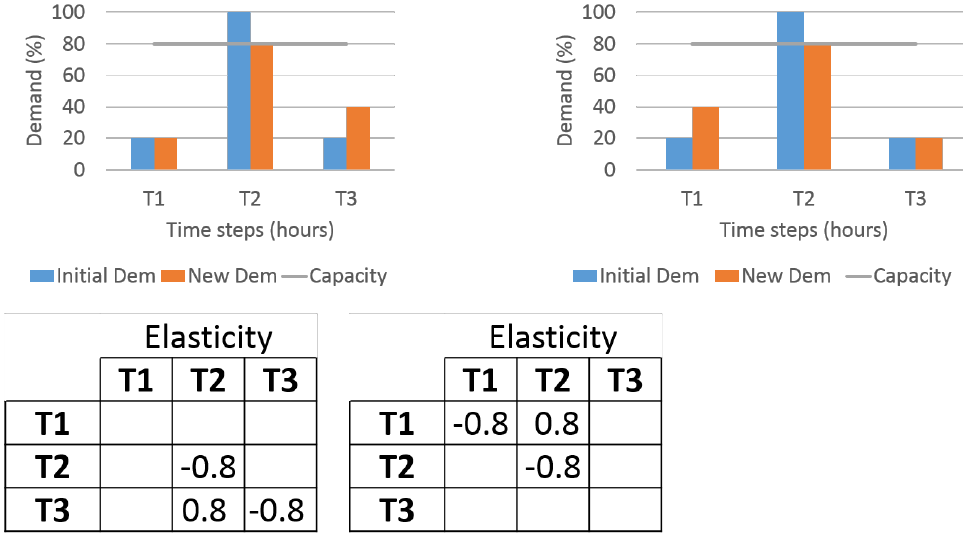
Figure 3. Simple example to understand how the elasticity affects the loads’ cut and shifting.